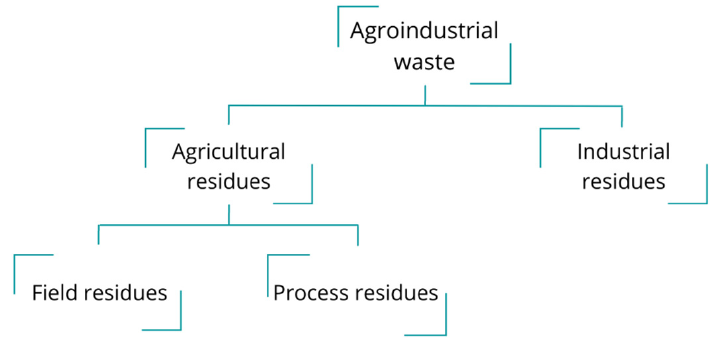
Figure 4. Classification of agro-industrial.